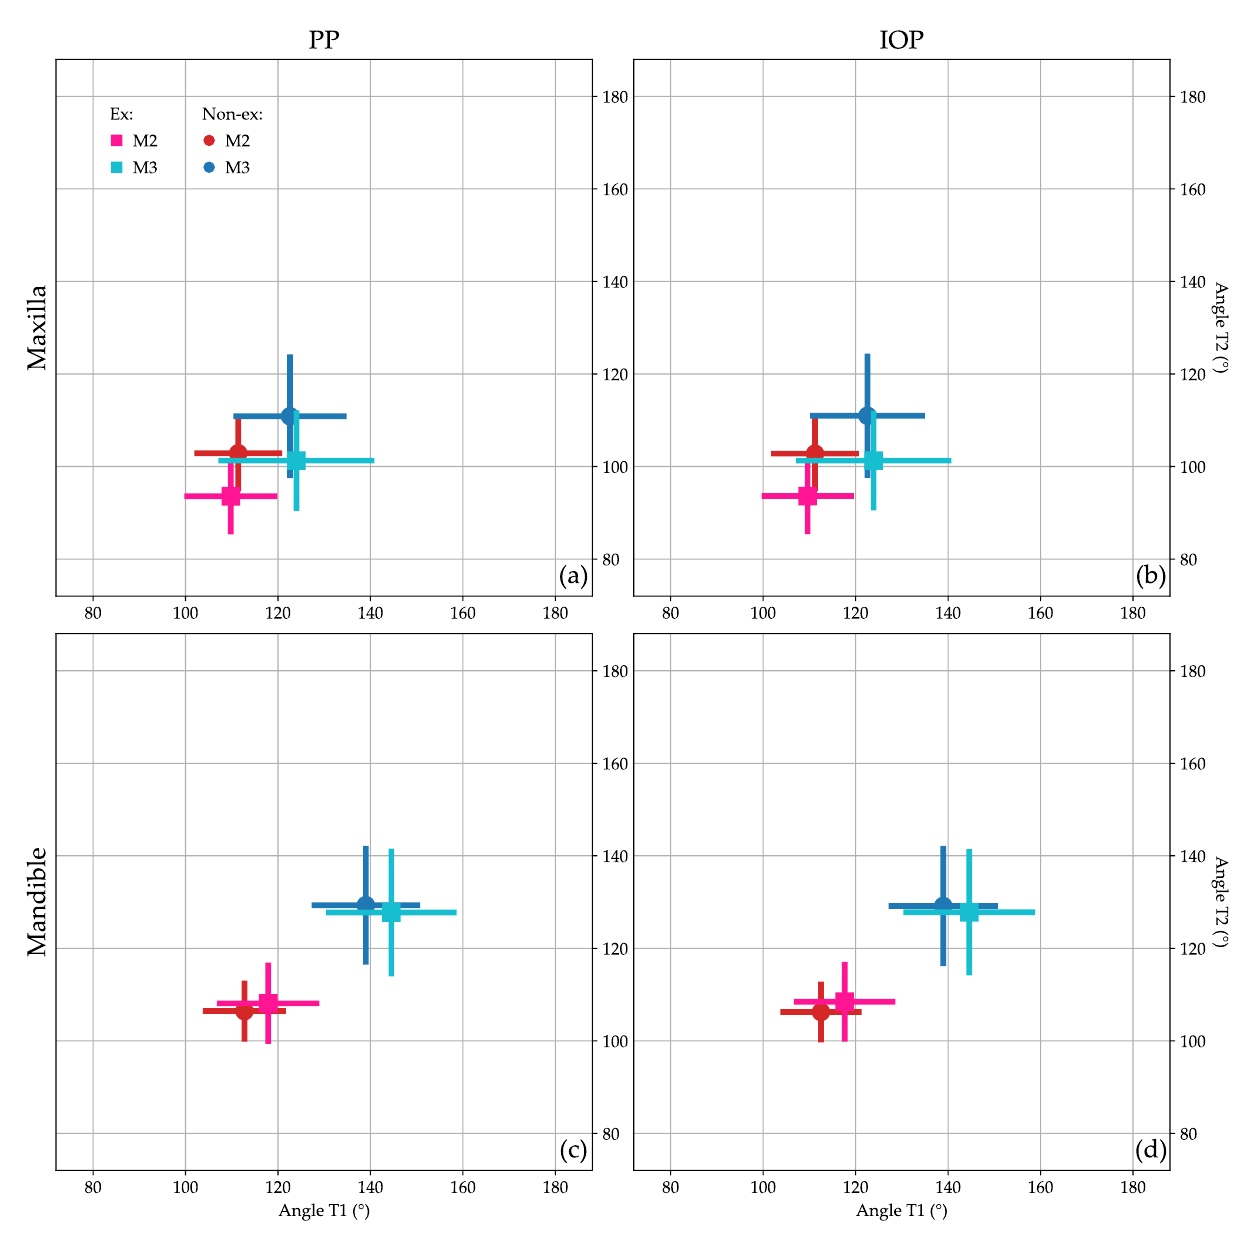
Figure 6. Patients ´ angular changes of M2 and M3 between the two examination time points (T1: Figure 6. Patients´ angular changes of M2 and M3 between the two examination time points (T1: x- Figure 6. Patients´ angular changes of M2 and M3 between the two examination time points (T1: x- Figure 6. Patients´ angular changes of M2 and M3 between the two examination time points (T1: x- Figure 6. Patients´ angular changes of M2 and M3 between the two examination time points (T1: x- Figure 6. Patients´ angular changes of M2 and M3 between the two examination time points (T1: x- axis, T2: y-axis). Means, standard deviations (cross), and distribution of the non-extraction (Non- axis, T2: y-axis). Means, standard deviations (cross), and distribution of the non-extraction (Non- x-axis, T2: y-axis). Means, standard deviations (cross), and distribution of the non-extraction (Non-ex): axis, T2: y-axis). Means, standard deviations (cross), and distribution of the non-extraction (Non- axis, T2: y-axis). Means, standard deviations (cross), and distribution of the non-extraction (Non- axis, T2: y-axis). Means, standard deviations (cross), and distribution of the non-extraction (Non- ex): (M2: ex): (M2: (M2: , M3: ex): (M2: ) groups. ( a ) maxillary M2/PP ex): (M2: and M3/PP; ( b ) maxillary M3/IOP and M3/IOP; ( c ) mandibular M2/PP and M3/PP; ( d ) mandibular and M3/PP; ( b ) maxillary M3/IOP and M3/IOP; ( c ) mandibular M2/PP and M3/PP; ( d ) mandibular and M3/PP; ( b ) maxillary M3/IOP and M3/IOP; ( c ) mandibular M2/PP and M3/PP; ( d ) mandibular and M3/PP; ( b ) maxillary M3/IOP and M3/IOP; ( c ) mandibular M2/PP and M3/PP; ( d ) mandibular ( b ) maxillary M3/IOP and M3/IOP; ( c ) mandibular M2/PP and M3/PP; ( d ) mandibular M2/IOP and M2/IOP and M2/IOP and M3/IOP. M3/IOP. M2/IOP and M3/IOP. M2/IOP and M3/IOP.